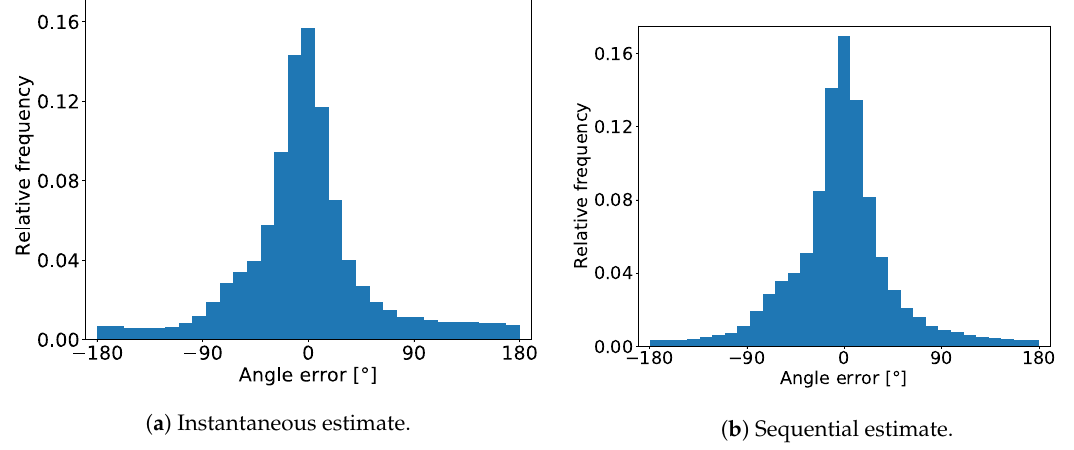
Figure 6. Distribution of body angle mean absolute